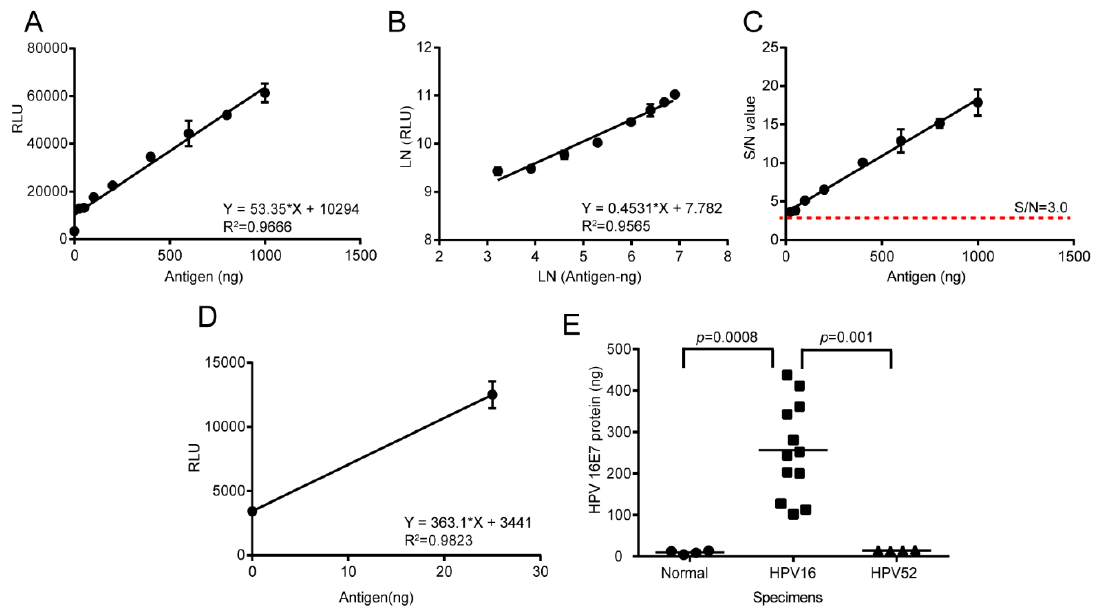
Figure 7. Preparation of reference curves and detection of clinical specimens by chemiluminescence immunoassay. ( A – C ) The straight ‐ line fitting, double ‐ logarithmic fitting, and S/N ratio of the reference curve for cervical cancer specimens. ( D ) The reference curve and equation for calculating the detection limit. ( E ) The HPV16 E7 content of 3 groups of tissues, including 4 normal cervical tissues, 12 HPV16 ‐ positive cervical cancer tissues and 4 HPV52 ‐ positive cervical cancer tissues. Twenty μ g of total protein per specimen was used for detection. The significance was shown by using the One ‐ way ANOVA with post ‐ hoc Tukey HSD for multiple comparison. RLU, relative light units.